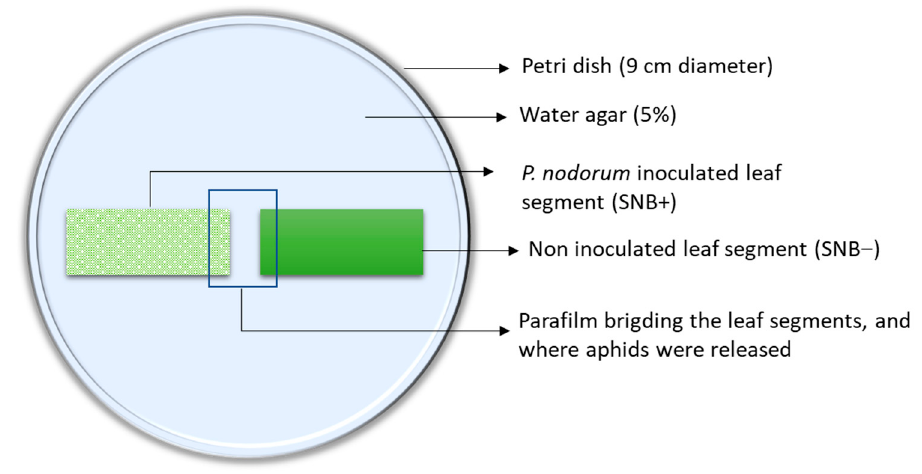
Figure 1. Aphid ( Rhopalosiphum padi ) choice experiment set up where aphids were placed on the paraffin film that served as a bridge between the Parastagonospora nodorum inoculated (SNB+) and non-inoculated ( SNB − ) leaves.